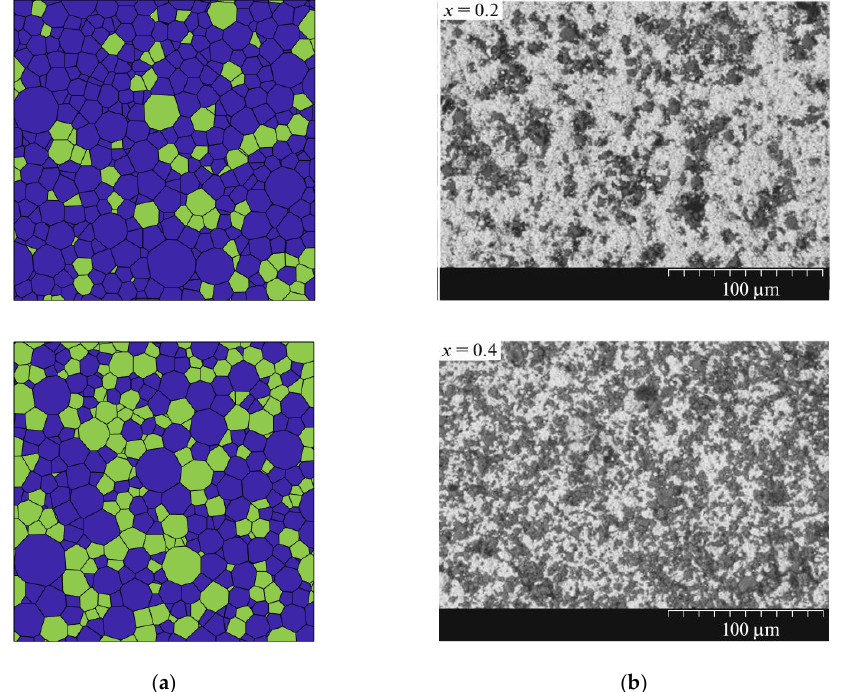
Figure 3. ( a ) The grain model of PZT matrix ferroelectric composites (blue grains are PZT, and green grains are ferrite). ( b ) SEM photos of PZT ceramics and composites of different compositions (light grains are PZT, and dark grains are ferrite—X is the proportion of ferrite volume) [31].